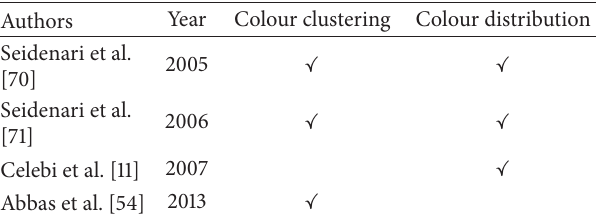
Table 2: Methods for capturing colour